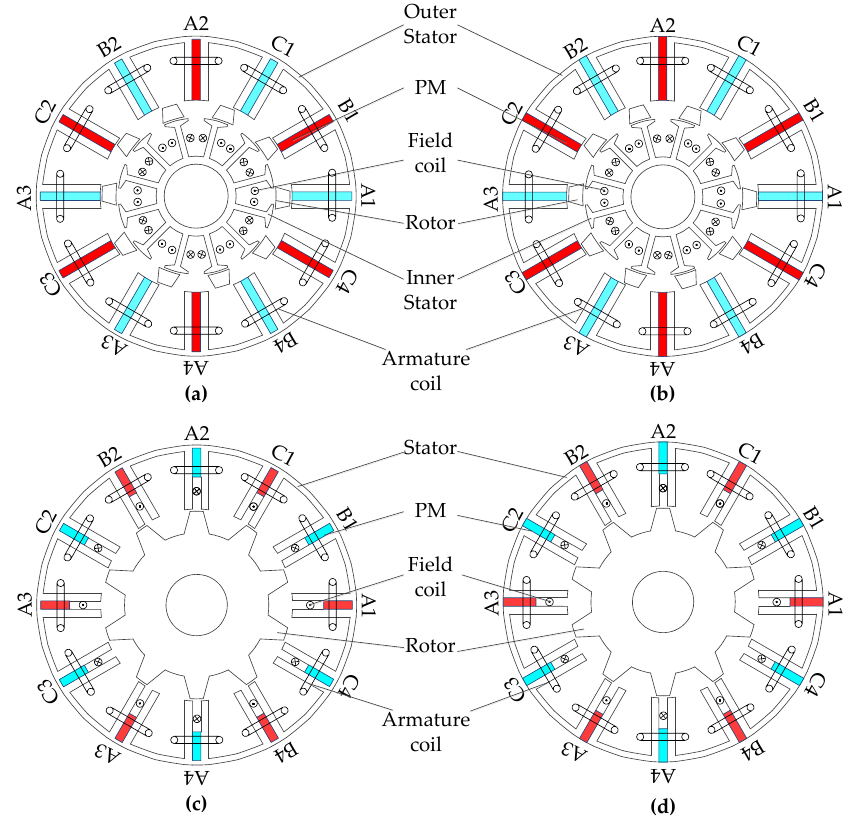
Figure 1. Cross-sections of machines. ( a ) PS-HEFS1; ( b ) PS-HEFS2; ( c ) HEFS1; ( d ) HEFS2.